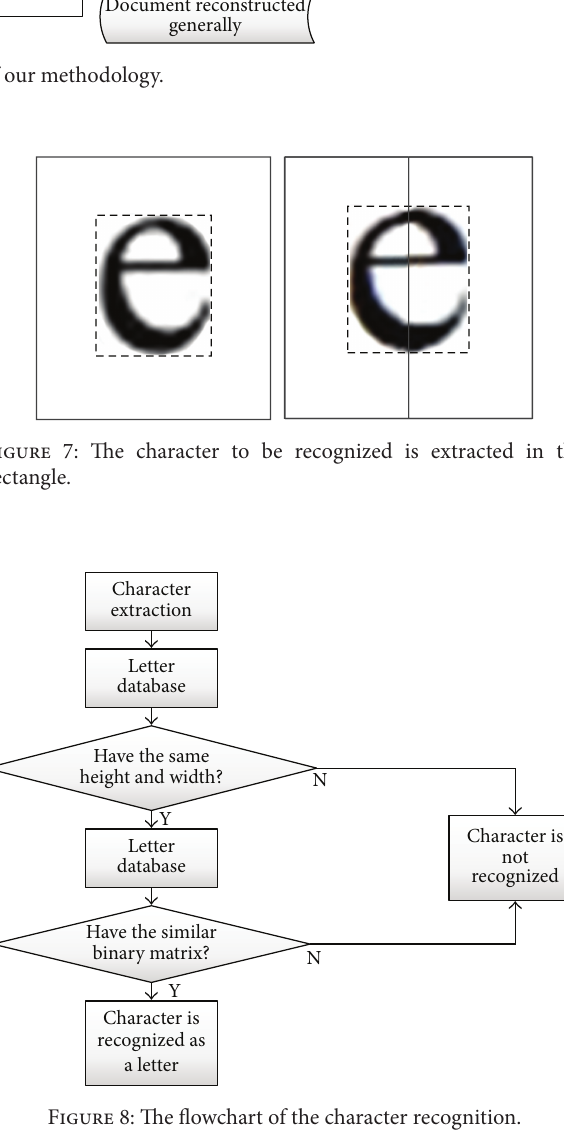
vector to describe a fragment. The binary gray image matrix of each fragment can be described as a 4 × 1 clustering vector through feature extraction. The clustering vector is defined as 𝑇 , where 𝑎 1 represents the lower position CV = (𝑎 1 , 𝑎 2 , 𝑎 3 , 𝑎 4 ) of the unidentified row on the top of the fragment and 𝑎 4 represents the upper position of the unidentified row at the bottommost of the fragment. Meanwhile, 𝑎 2 represents the position of the overline of the last identified row, and 𝑎 3 represents the position of the underline of the last identified